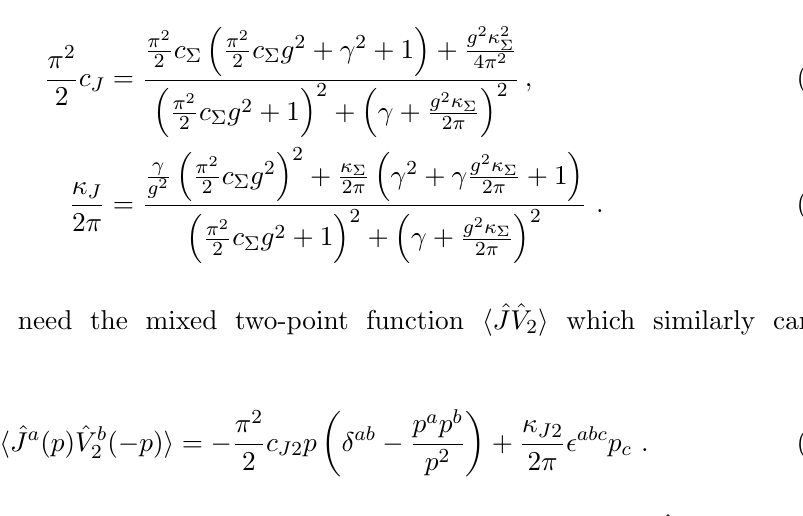
Figure 19 . Relations between the two-point functions involving the current V function JJ . The relation in the second line is only true up to a contact term. h i where (cid:5) is the boundary propagator of the photon (see eq. (2.46))